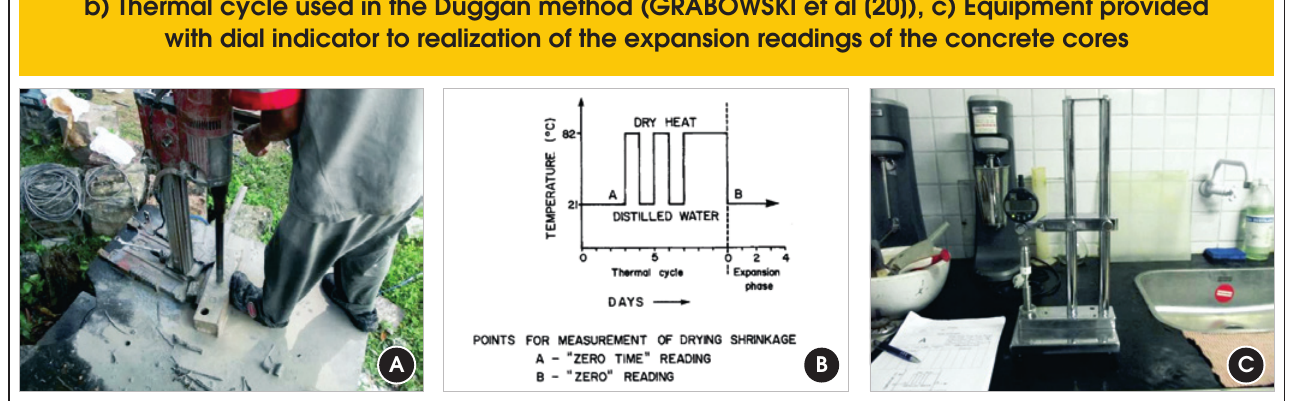
Figure 6 – Steps of the Duggan test: a) Extraction of the concrete cores through drill